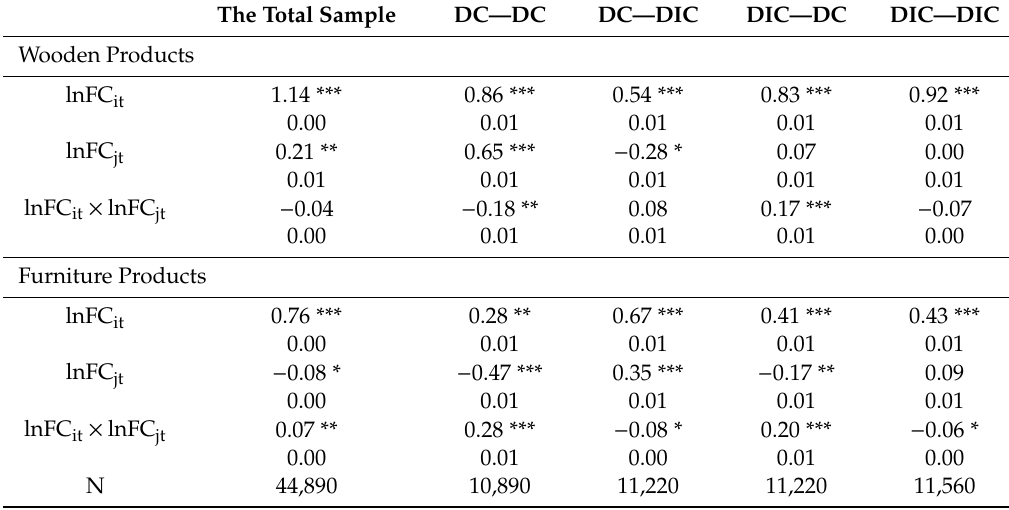
Table 8. PPML (MR) regression results of product